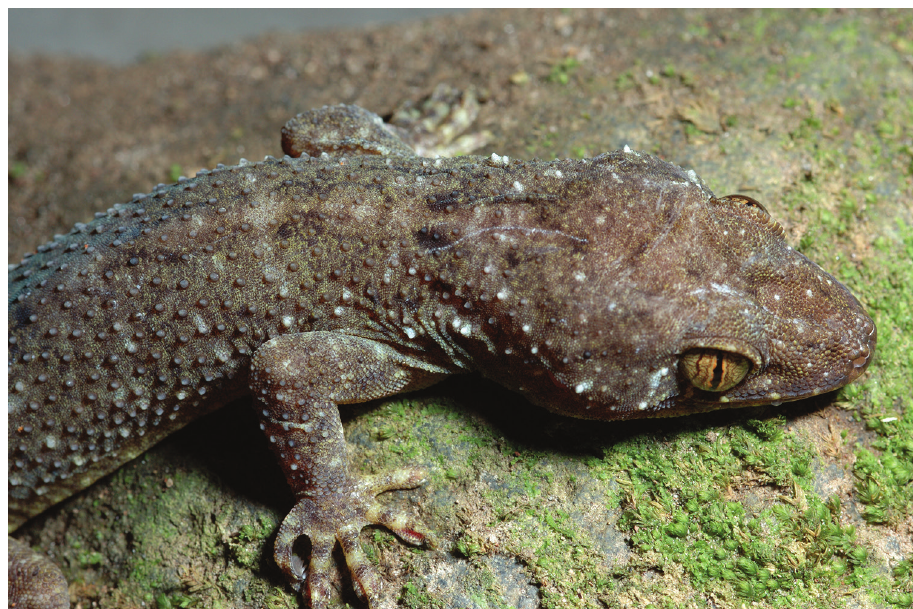
Figure 49. Gekko cf. mindorensis (specimen not collected) from Municipality of Mambajao, Mt. Mam- bajao, Camiguin Sur Island. Photo: